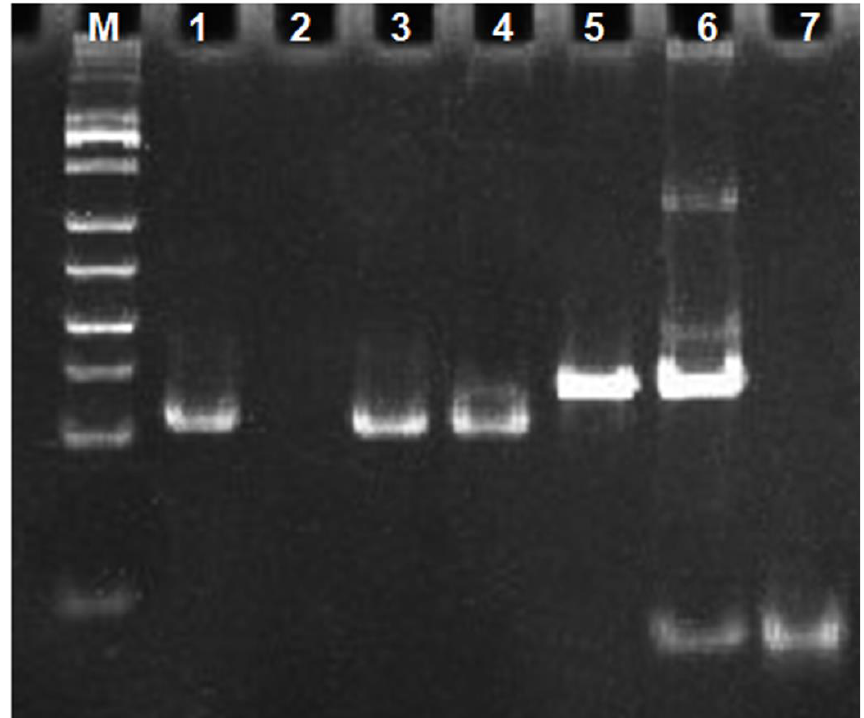
Figure 3. Gel electrophoresis analysis diagram. (M) DNA marker; (1) H; (2) primer-3; (3) pri-